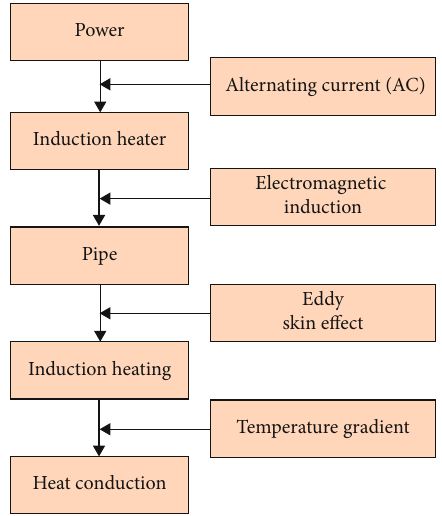
Figure 2: Simpli fi ed diagram of lining induction heating